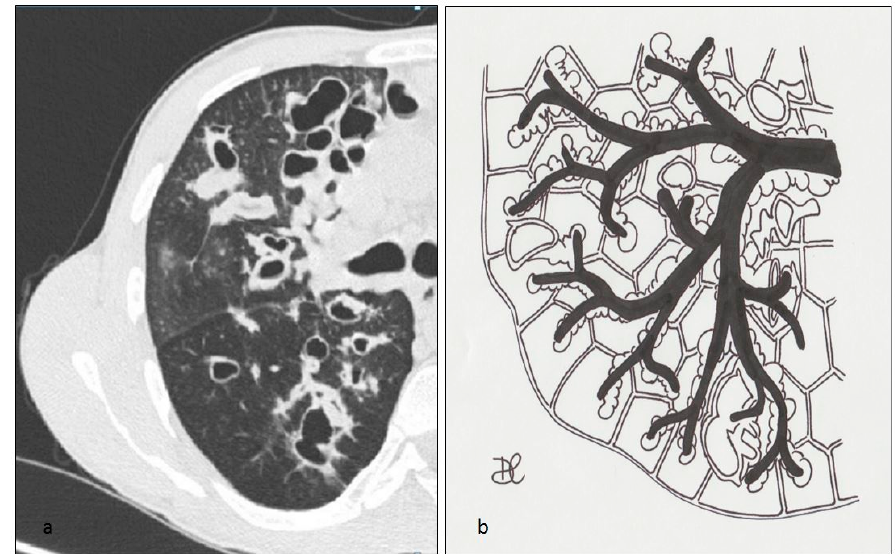
Figure 17. Cystic fibrosis (CF) pattern ( a ), multiple cystic lesions, represented by cystic bronchiectasis, filled by mucous secretion, abscess cavities or bullae, mainly located in subpleural and upper zones of the lung; these bronchiectases may be variable in size, with regular shape, wide distribution and thickened walls ( b ). Diagnostics 2020 , 10 , x FOR PEER REVIEW